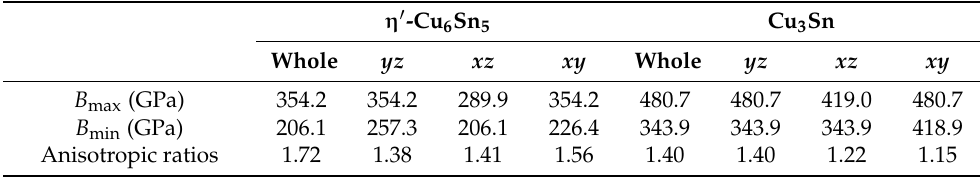
Table 8. The anisotropic ratios, maximum and minimum values of B for η (cid:48) -Cu 6 Sn 5 and Cu 3 Sn. η (cid:48) -Cu 6 Sn